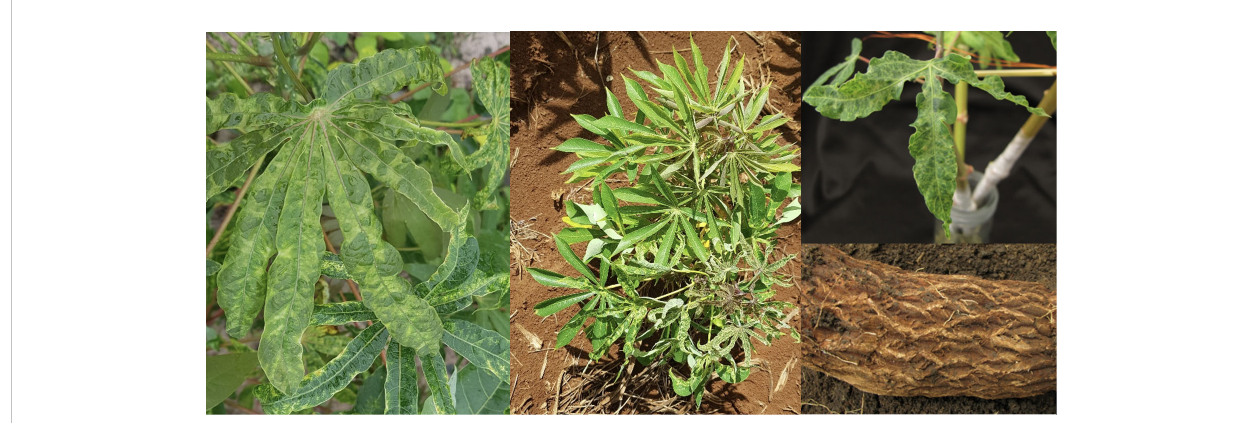
FIGURE 3 Left: Characteristic leaf symptoms of cassava mosaic disease (CMD), a disease associated with 12 different species of begomoviruses, affecting cassava in Africa, East Asia and Southeast Asia (Legg et al., 2015). Center: Cassava plant in Southeast Asia showing mixed symptoms of CMD (caused by Sri Lankan cassava mosaic virus) and cassava witches ’ broom disease, a co-infection common in the region (Siriwan et al., 2020). Right: Leaf and root symptoms of cassava frogskin disease associated with a unique virome from the Americas (Pardo et al., 2022). Photos: W.